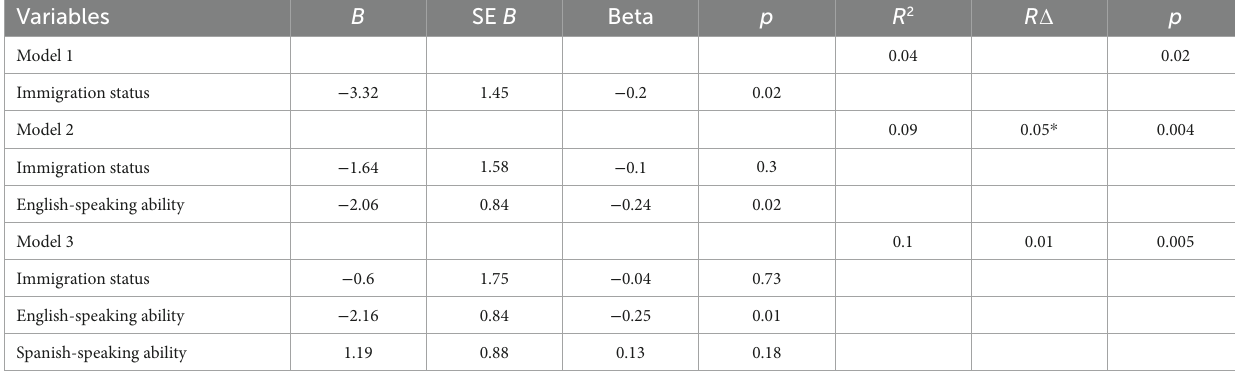
TABLE 2 Sequential multiple regression of potential determinants of the delay to first prescribed medication after psychosis onset.